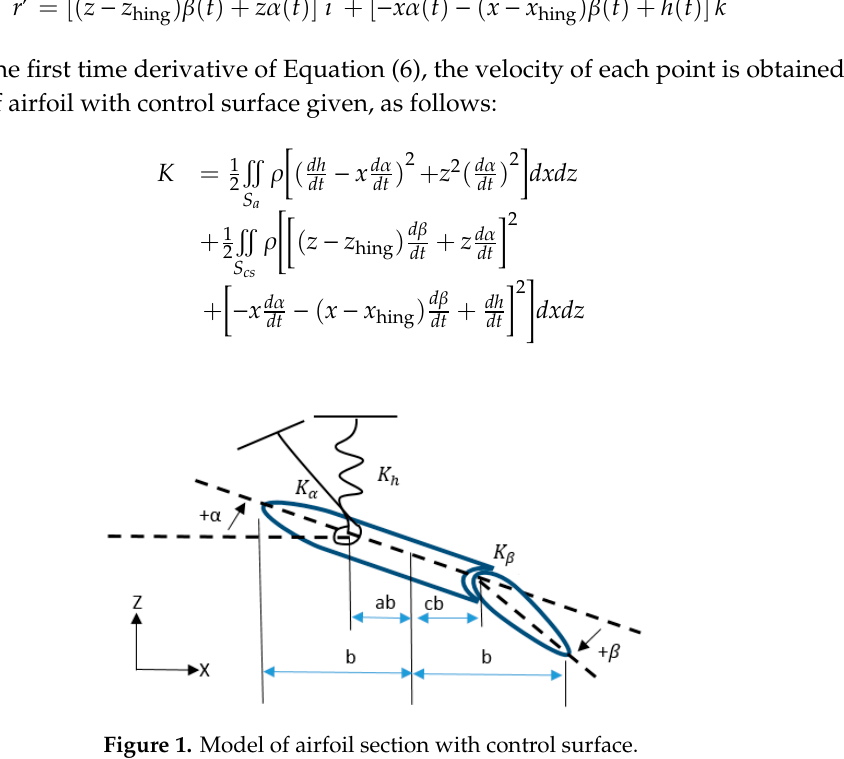
Figure 1. Model of airfoil section with control surface.